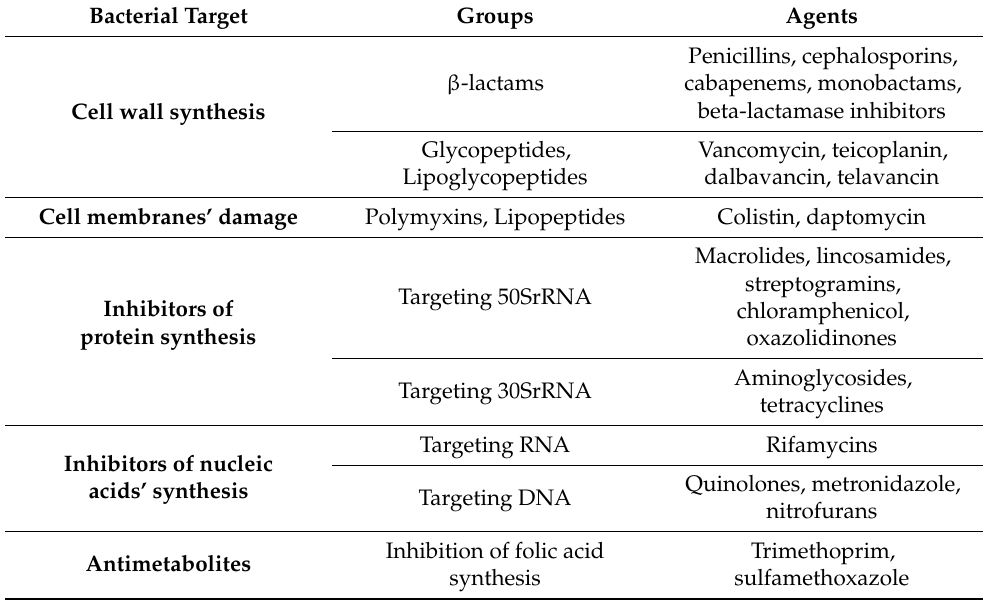
Table 1. Antibacterial agents and their targets in bacteria. Bacterial Target Groups Agents